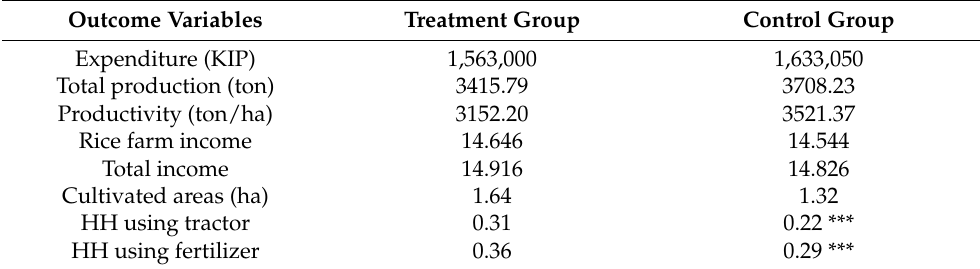
Table 3. Comparison of the mean of some of the variables in the baseline survey (2003). Outcome Variables